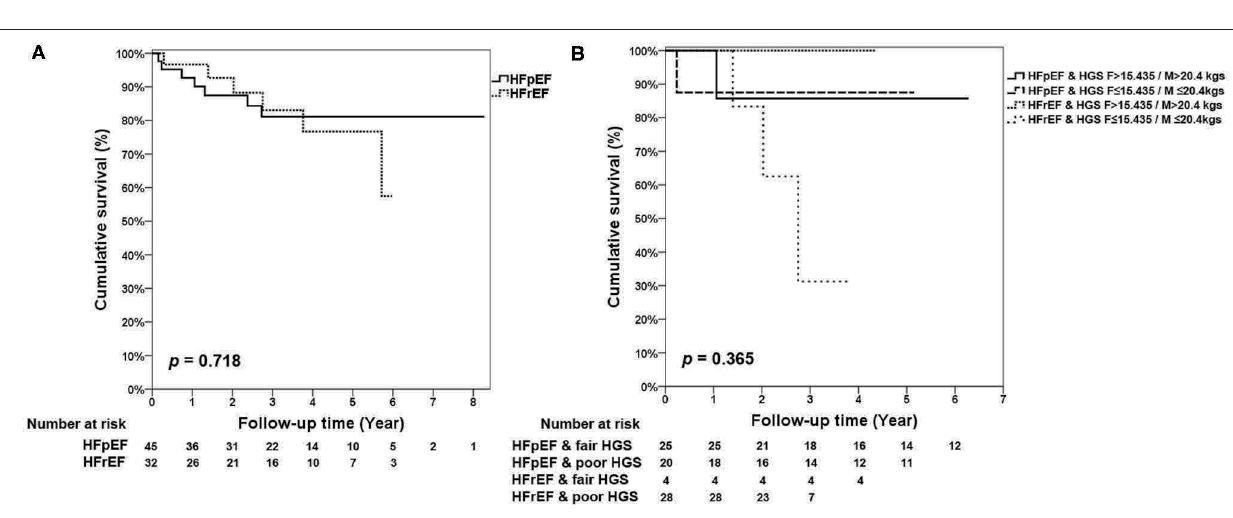
disease progression and poor prognosis of HF (36, 39). Digoxin is predominantly excreted by the kidneys, and influenced, resulting in toxicity of nausea and vomiting,